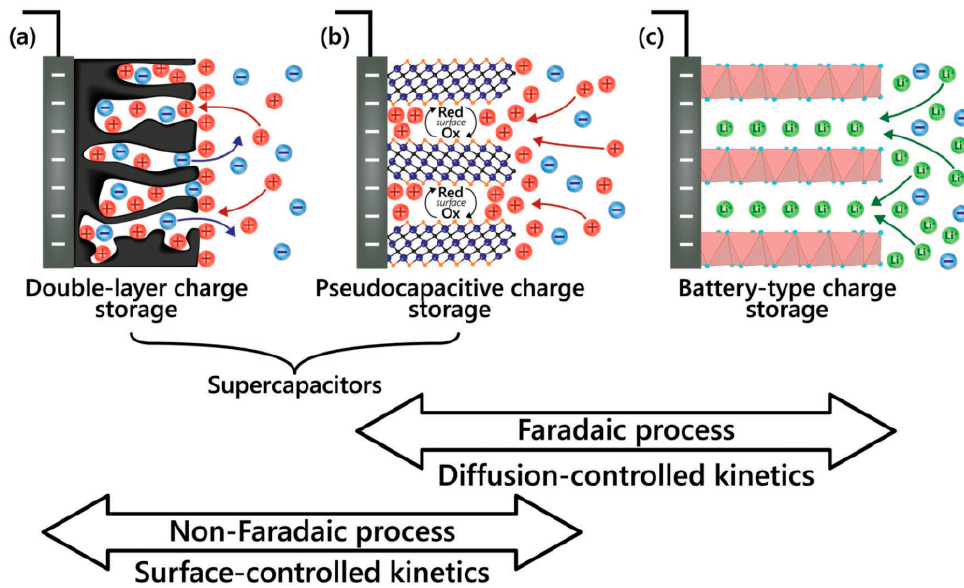
Figure 2. Illustration of the electrode processes occurring at electrical double-layer capacitive ( a ), pseudocapacitive ( b ), and faradaic ( c ) electrodes (Reproduced with permission of [13]. Copyright Wiley, 2019).